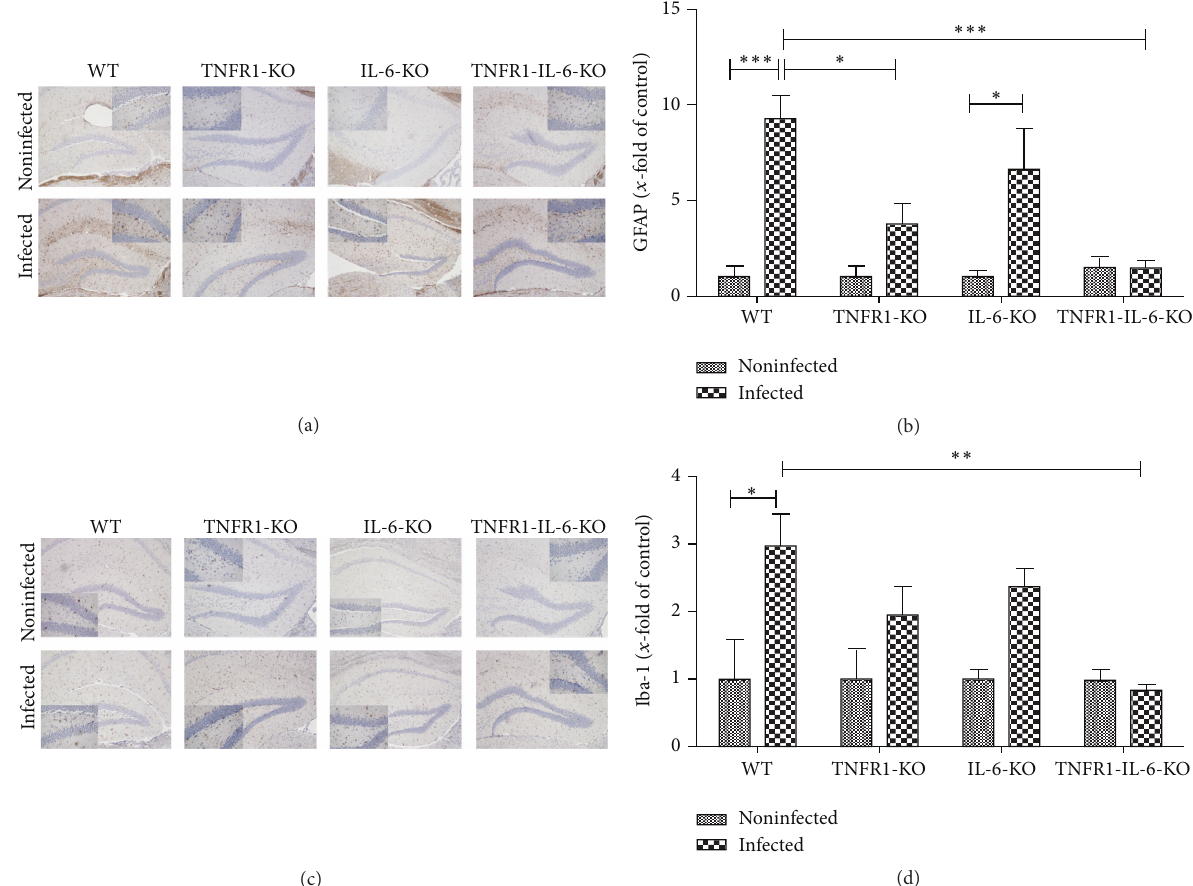
Figure 2: Glial cell density in the hippocampus 30 h after pneumococcal meningitis. Coronal brain sections stained with antibodies against GFAP to identify astrocytes (a) or Iba-1 to identify activated microglial cells (c) 30 h after infection with Streptococcus pneumoniae. A detailed section was included. GFAP (b) and Iba-1 (d) immunoreactive cells were quantified per mm 2 area of the hippocampal formation of infected and healthy mice and represented as 𝑥 -fold of control. Immunoreactive cells were normalized to noninfected controls. The asterisk indicates a significant difference between the animals groups (each group 𝑛 = 5 ) mice as determined by ANOVA followed by Bonferroni test ( ∗ 𝑝 < 0.05 ; ∗∗ 𝑝 < 0.01 ; ∗∗∗ 𝑝 < 0.001